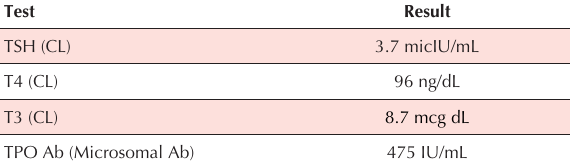
Table 2. Lab data after treatment with levothyroxine